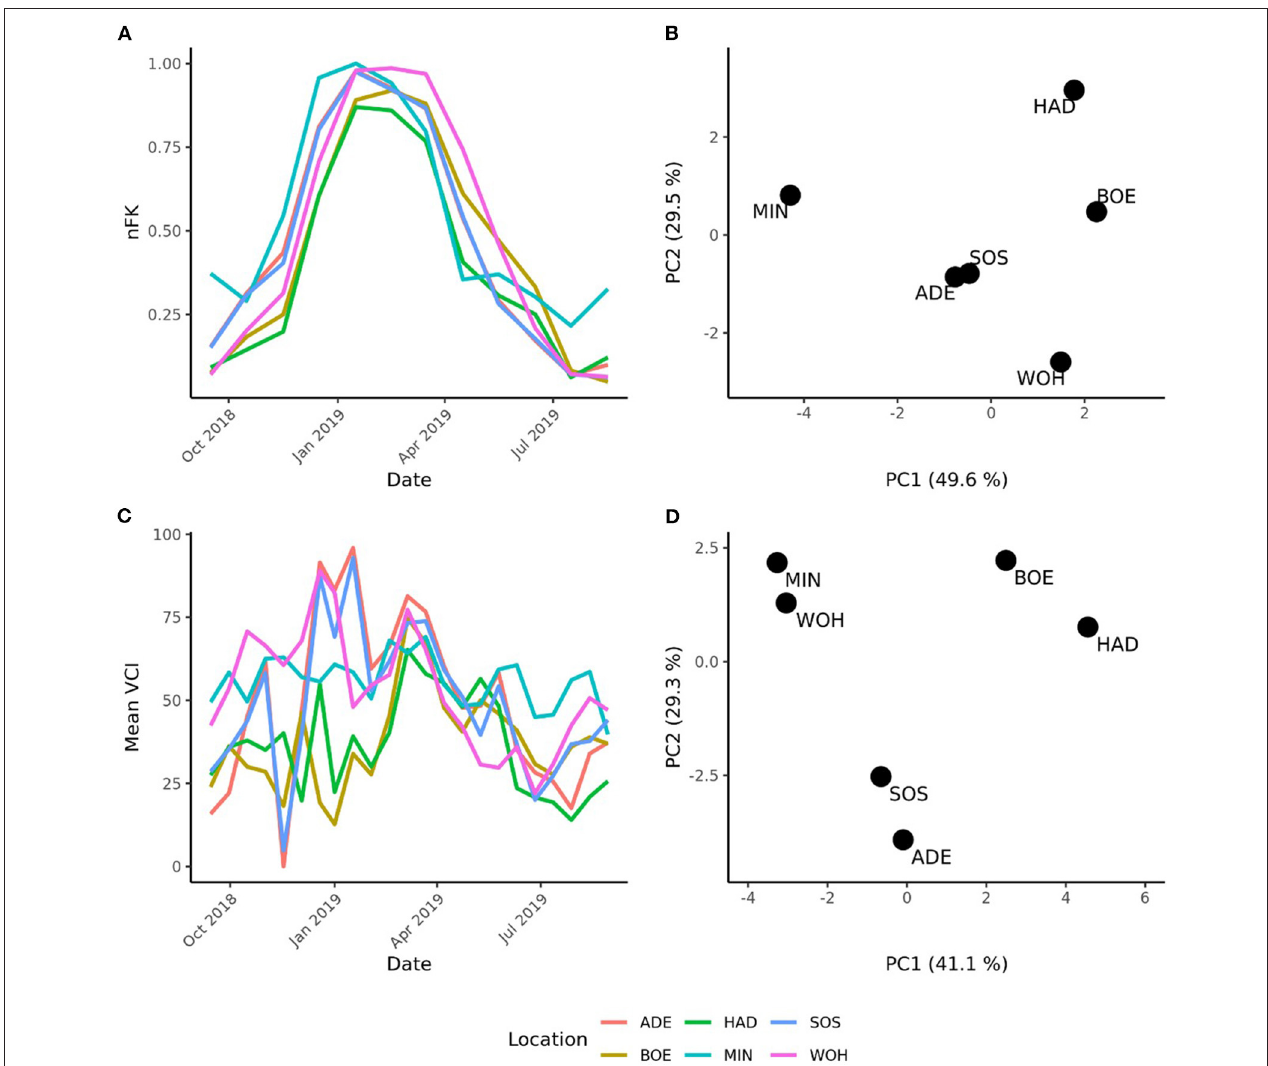
FIGURE 3 | Characterization of the locations used to assess the selection gain of the reciprocal recurrent genomic selection program. (A) Line plot of the plant available water (PAW) in the soil and (B) a principal component analyses (PCA) based on the PAW profiles of the locations recorded in the growing season [September 1st in the year of sowing (2018) to September 1st in the year of harvest (2019)]. (C) Line plot of the mean vegetation condition index (VCI), and PCA based on the mean VCI profiles of the locations recorded in the growing season (D) . The locations were indicated as ADE, Adenstedt; BOE, Boehnshausen; HAD, Hadmersleben; MIN, Mintraching; SOS, Sossmar; WOH,